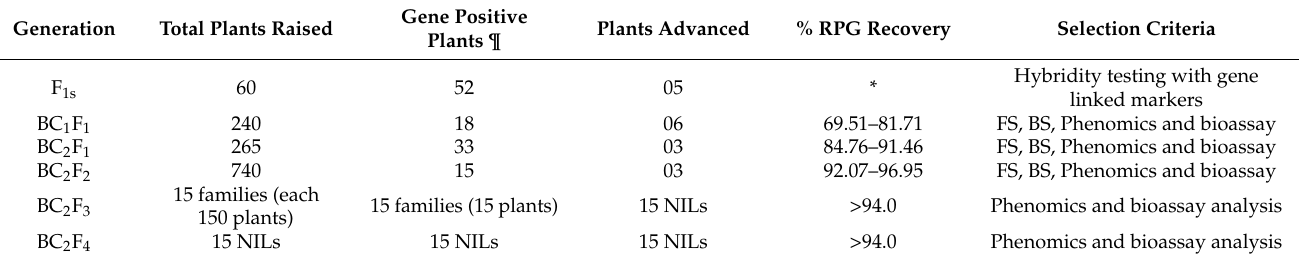
Table 3. Brief summary of crosses and RP genome recuperation in the NILs of HUR